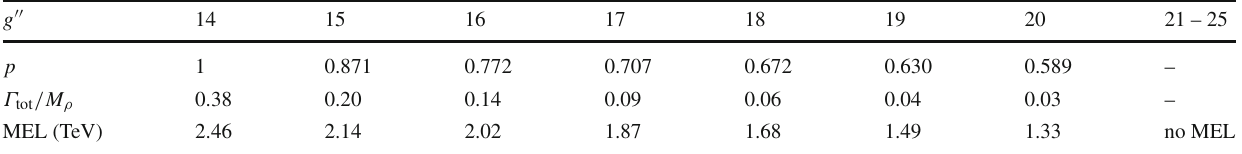
Table 5 The smallest tBESS resonance mass exclusion limits (MEL) within the interval 0 ≤ p ≤ 1 assuming b L = 0 and b R = 0 . 1 for var- ious values of g (cid:2)(cid:2) . The second and third rows contain, respectively, the g